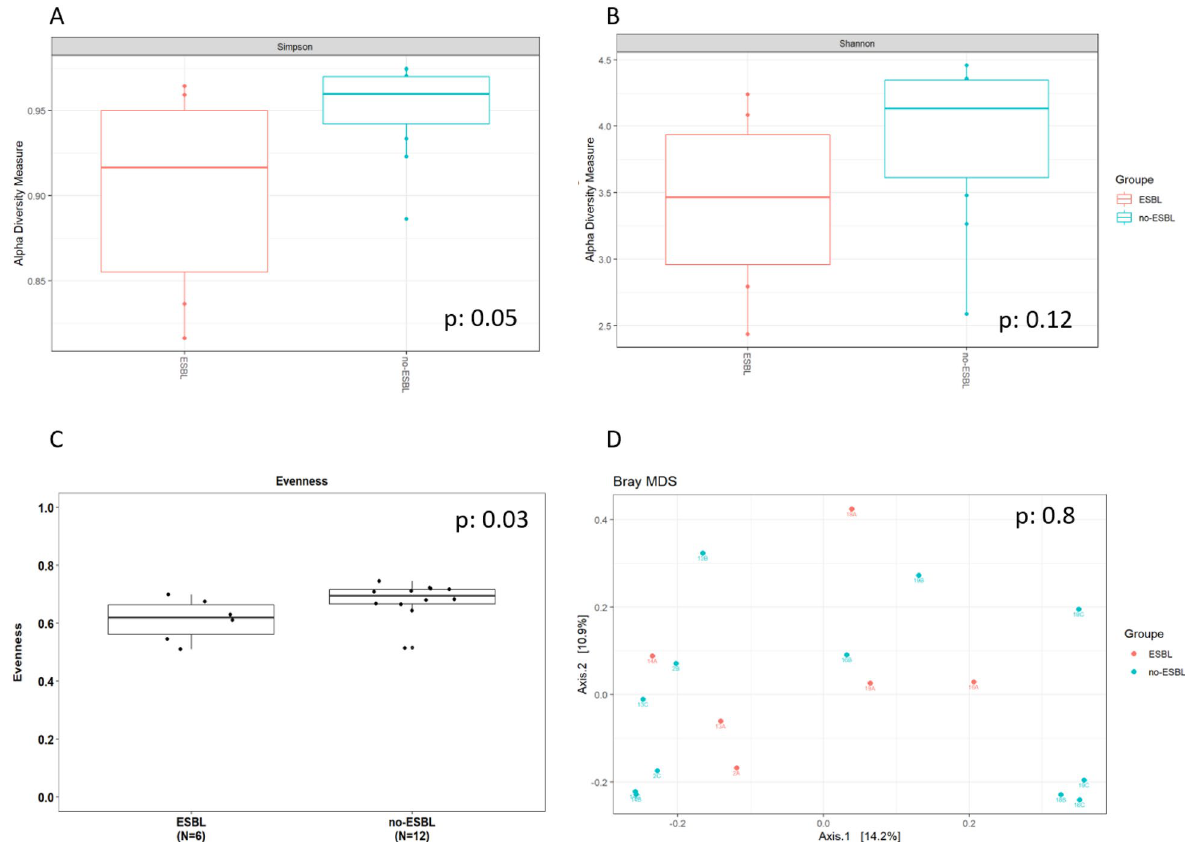
Fig. 4 Comparison of gut bacteriobiota between critically ill ESBL-producing Klebsiella pneumoniae faecal carriers (in red) and matched non ESBL-E faecal carriers (in blue). A . Boxplot of estimated α-diversity by Shannon index. B . Boxplot of estimated α-diversity by Simpson index. C . Boxplot of estimated α-diversity by evenness. D . Metric Bray–curtis analysis of β-diversity. Threshold for statistical significance: p